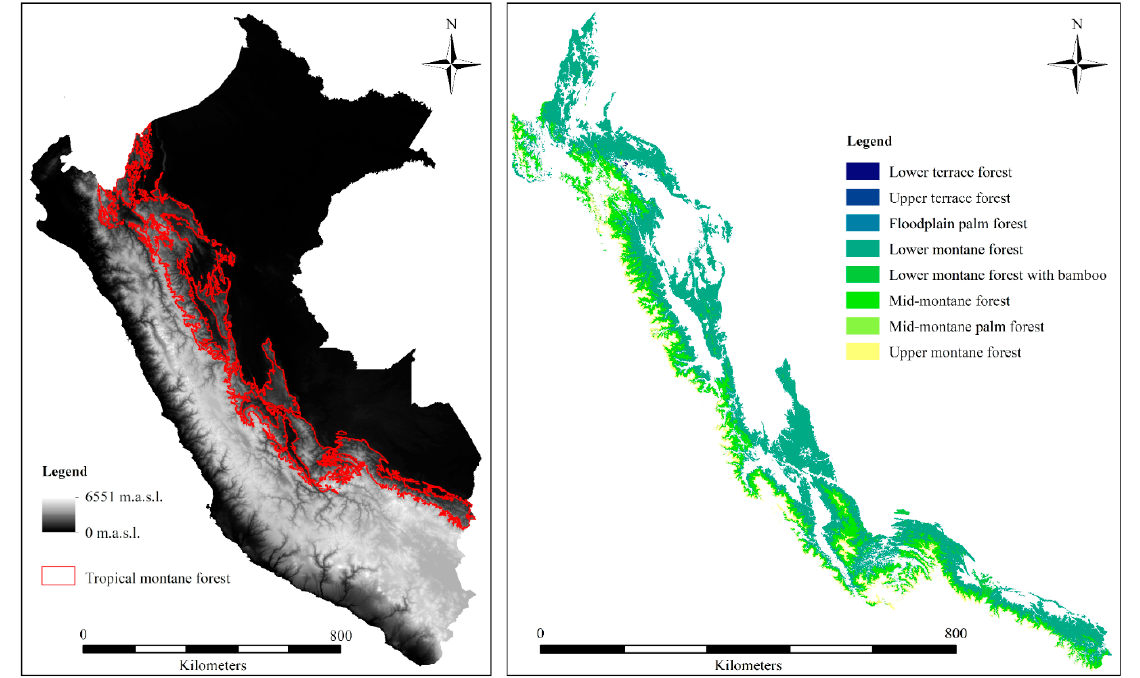
Figure 1. Left : Digital Elevation Model (DEM) with the distribution of tropical montane forests in Peru. Right : Distribution of the eight different forest types that correspond to tropical montane forest.